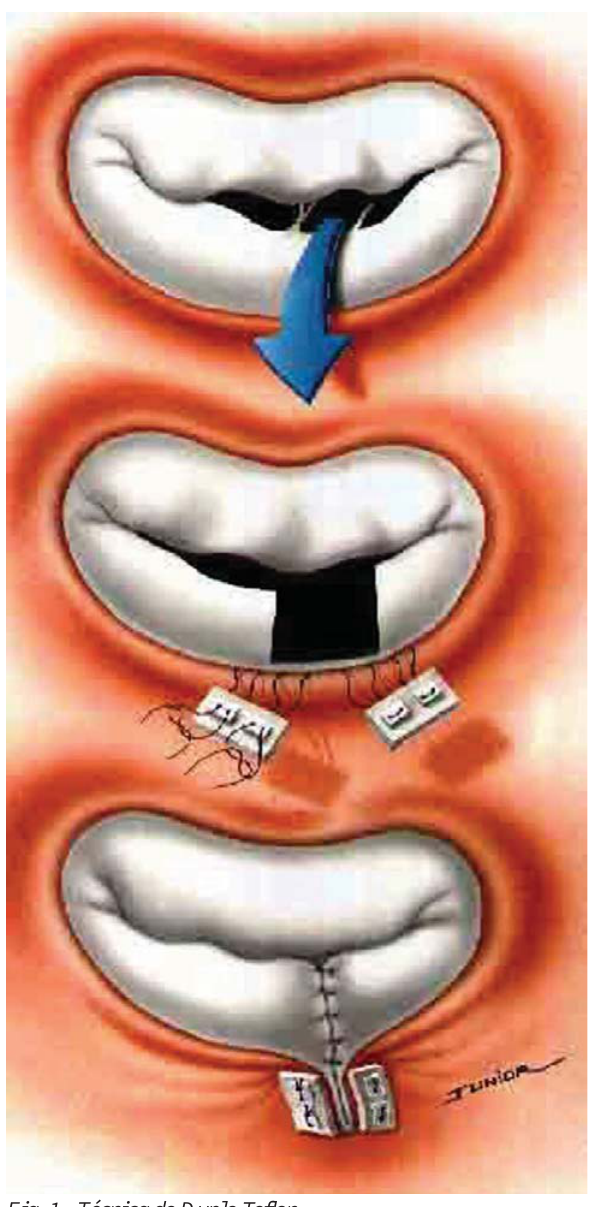
Fig. 1 - Técnica do Duplo